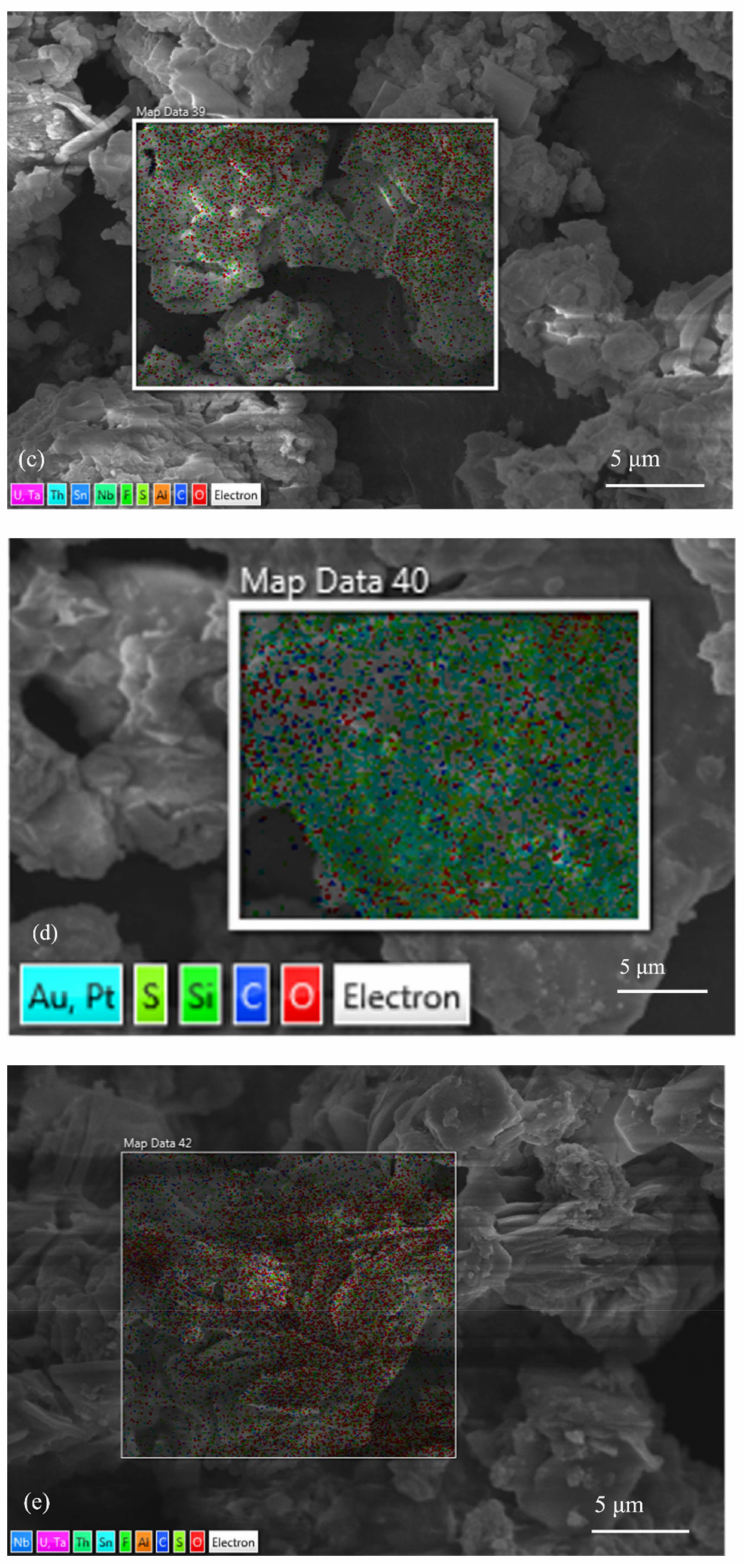
Figure 6. EDS results of tantalum-niobium slag roasted at ( a ) 200 ◦ C; ( b ) 300 ◦ C; ( c ) 400 ◦ C; ( d ) 500 ◦